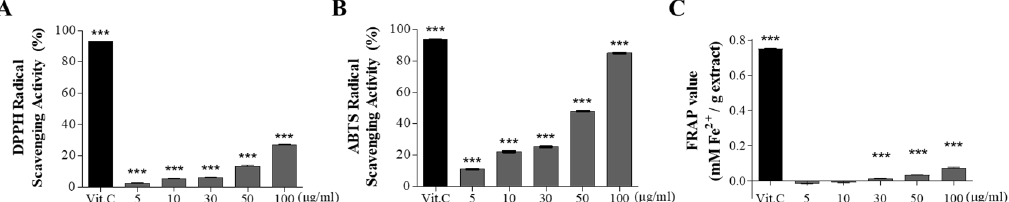
Figure 1. Antioxidant effects of CBE. ( A ) 2,2-Diphenyl-1-picrylhydrazyl (DPPH) radical scavenging assay. ( B ) 2,2 ′ -Azino-bis(3-ethylbenzothiazoline-6-sulfonic acid) (ABTS) radical scavenging assay. (C) Ferric reducing antioxidant power (FRAP) assay. The values are the mean ± SD (n ≥ 4). *** p < 0.001 vs. blank group, one-way ANOVA with Tukey’s post hoc test.